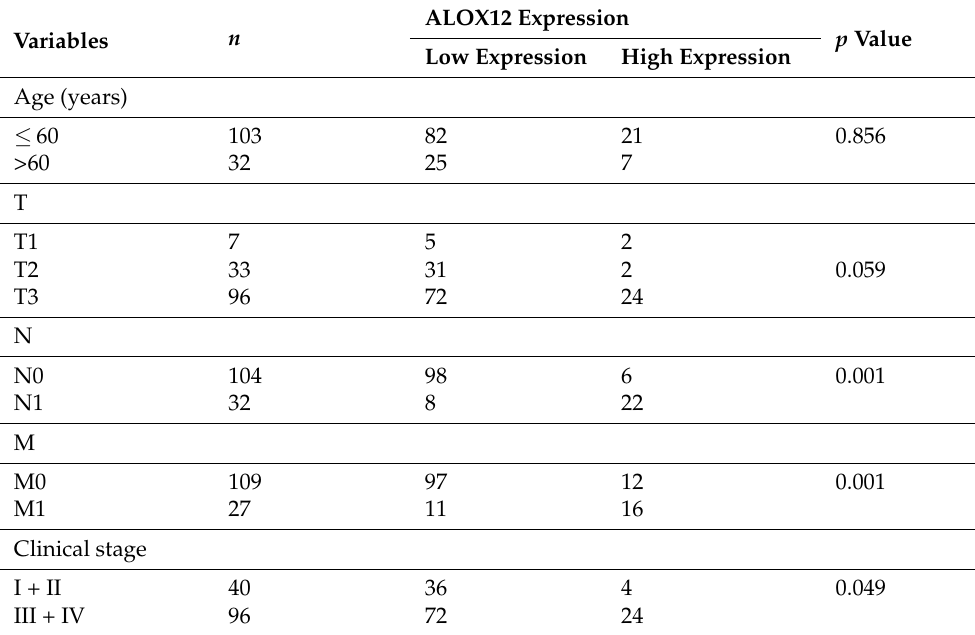
Table 2. Expression and clinicopathological characteristics of ALOX12 in ovarian